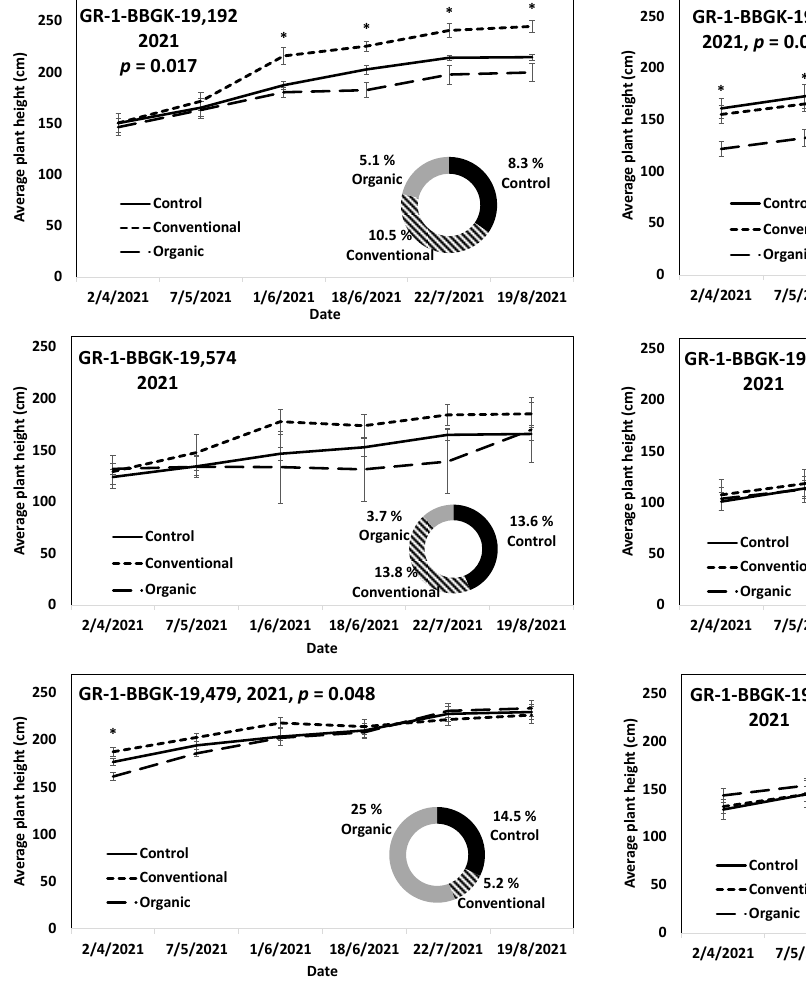
Figure 3. Plant growth patterns expressed as average plant height (cm) for Sambucus nigra genotypes GR-1-BBGK-19,192, GR-1-BBGK-19,73, GR-1-BBGK-19,562, GR-1-BBGK-19,574, GR-1-BBGK-19,629, GR-1-BBGK-19,637, GR-1-BBGK-19,479, GR-1-BBGK-19,596, and GR-1-BBGK-19,425 during the second year of the pilot field trial (2021) for the three fertilization treatments applied (control, conventional, and organic). Standard errors of the means are shown on the graphs ( p < 0.05).